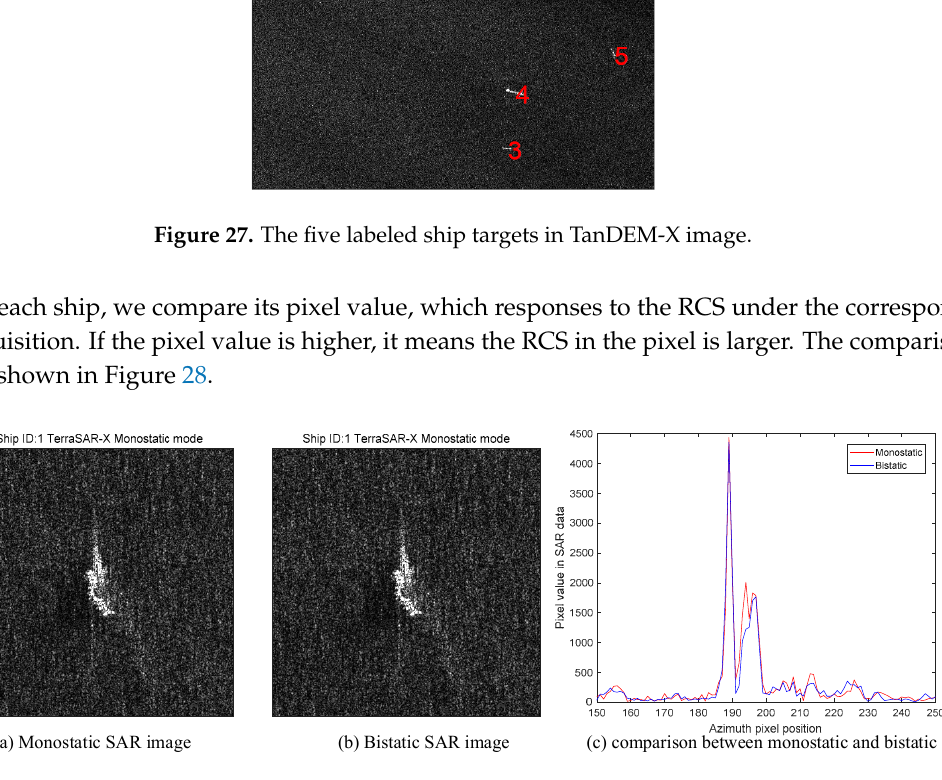
Figure 28. Comparison results of ship 1 ( a ) monostatic; ( b ) bistatic; ( c ) comparison curves.